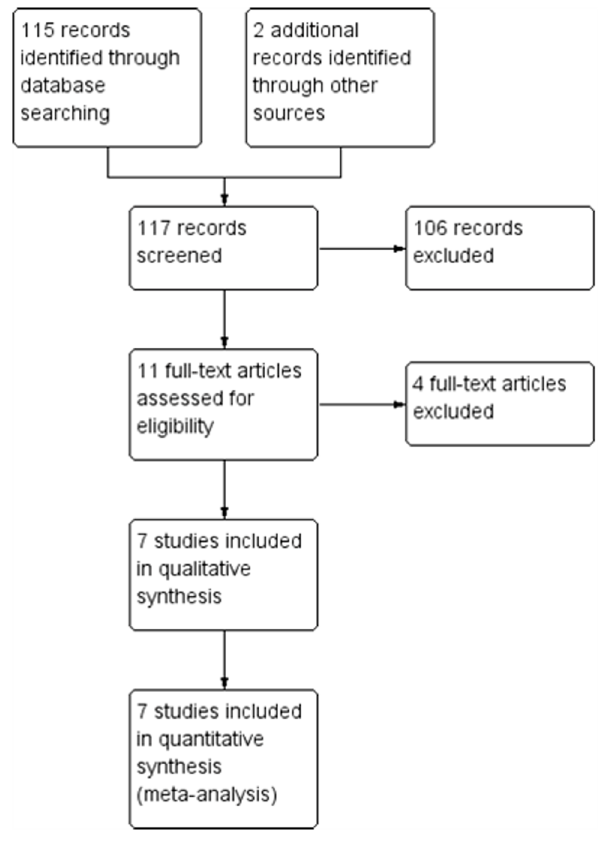
Fig 1. Search and selection of studies for systematic review according